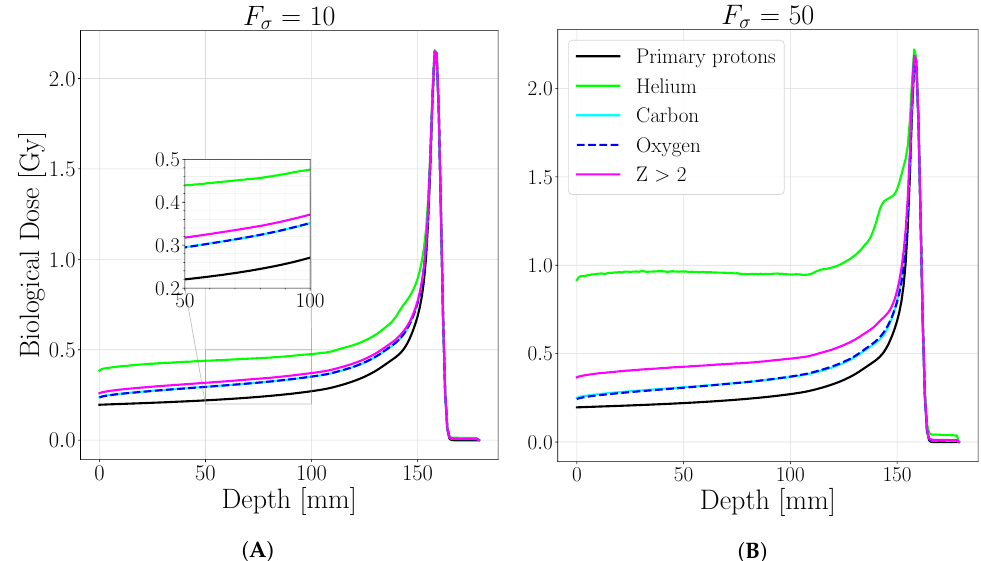
Figure A1. Biological dose distribution in depth of a proton beam with initial energy of 150 MeV/u obtained by considering fluence spectra with a scaled cross-section, F σ = 10 ( A ) and F σ = 50 ( B ), for Helium, Carbon, Oxygen, Z > 2. The primary protons’ biological dose is reported without scaling factor to give a direct comparison of the enhancement. The legend stands for both